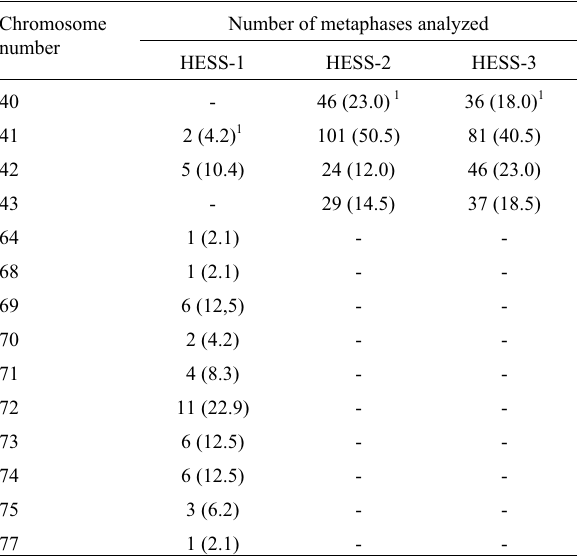
Table I - Frequency of different chromosome numbers in 7-day embryoid bodies derived from HESS-1, HESS-2 and HESS-3 hybrid cells. Chromosome